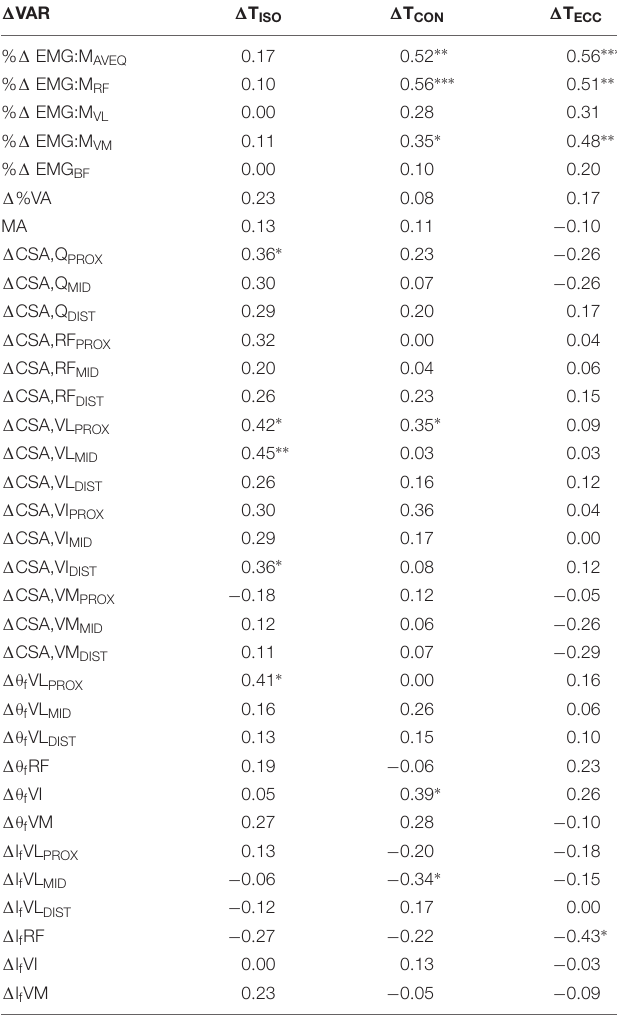
TABLE 6 | Correlations (r) between the change in isometric ( (cid:49) T ISO ), and isokinetic concentric ( (cid:49) T CON ) and eccentric ( (cid:49) T ECC ) torque and changes in neuromuscular variables ( (cid:49)